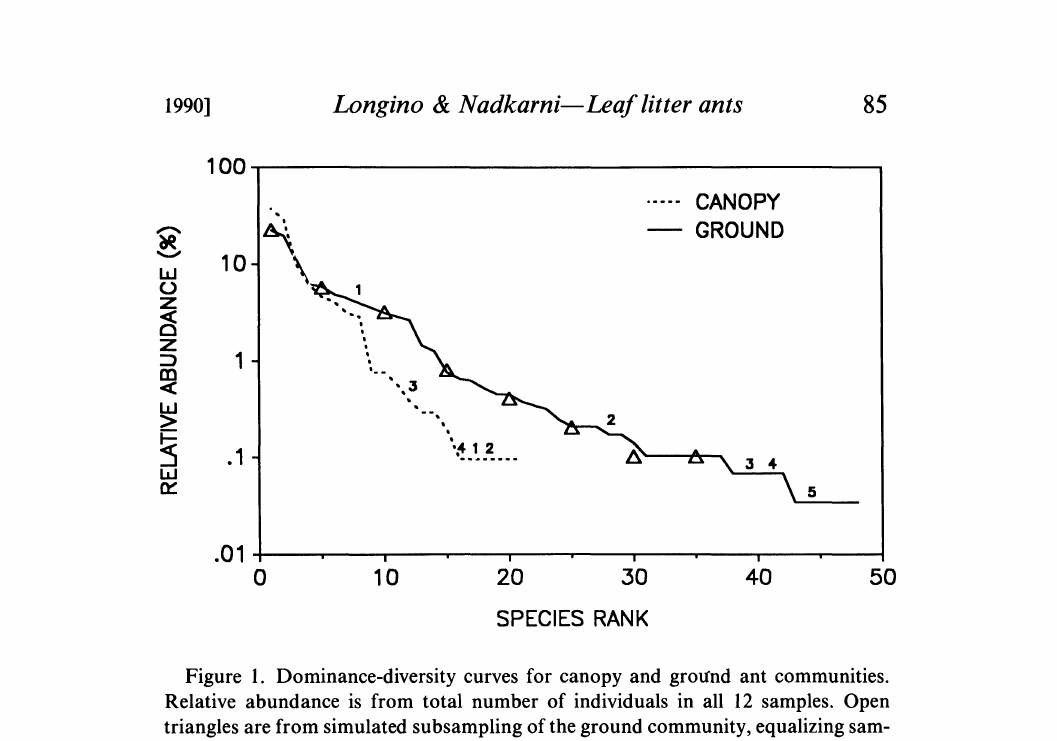
Figure 1. Dominance-diversity curves for canopy and ground ant communities. Relative abundance is from total number of individuals in all 12 samples. Open triangles are from simulated subsampling of the ground community, equalizing sam- ple sizes for ground and canopy. Numbers above curves are the rank of a given species in the alternate microhabitat, for the 5 most abundant species in each micro- habitat (the fifth most abundant species on the ground did not occur in the canopy). Note that species with high relative abundance in one microhabitat have low relative abundance in the